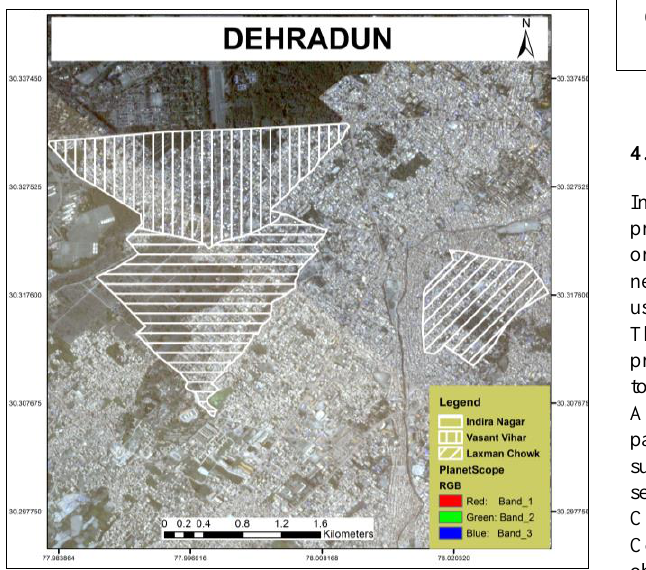
Figure 1. Study Area Map